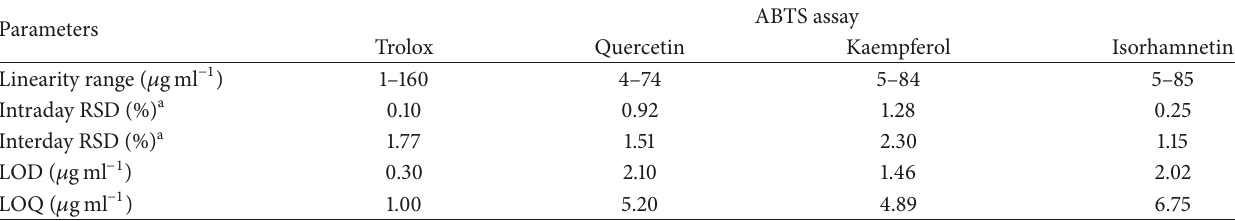
Table 3: Validation characteristics of the ABTS postcolumn assay.